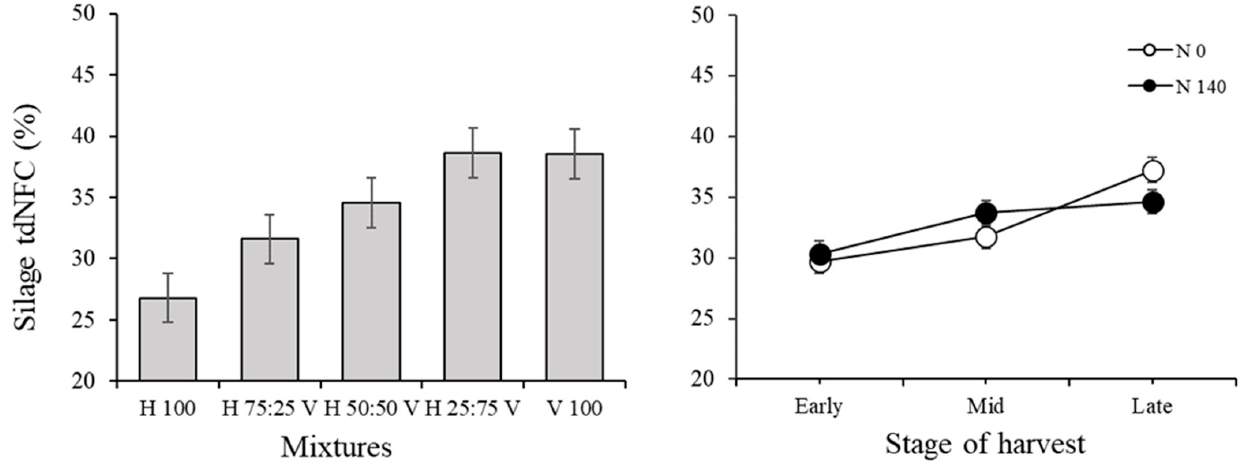
Figure 14. Silage tdNFC concentration as affected by MX mean effect ( left ) and SH × NF interaction ( right ). On the left, values are LSmeans across all treatments along with standard error estimate of the LSmeans since the design was unbalanced between the faba bean crop ( n = 9) compared to the mixtures and the barley crops ( n = 18). On the right, only data of the barley-containing treatments were used. Each point represents the arithmetic mean ( n = 24) and its computed standard error.